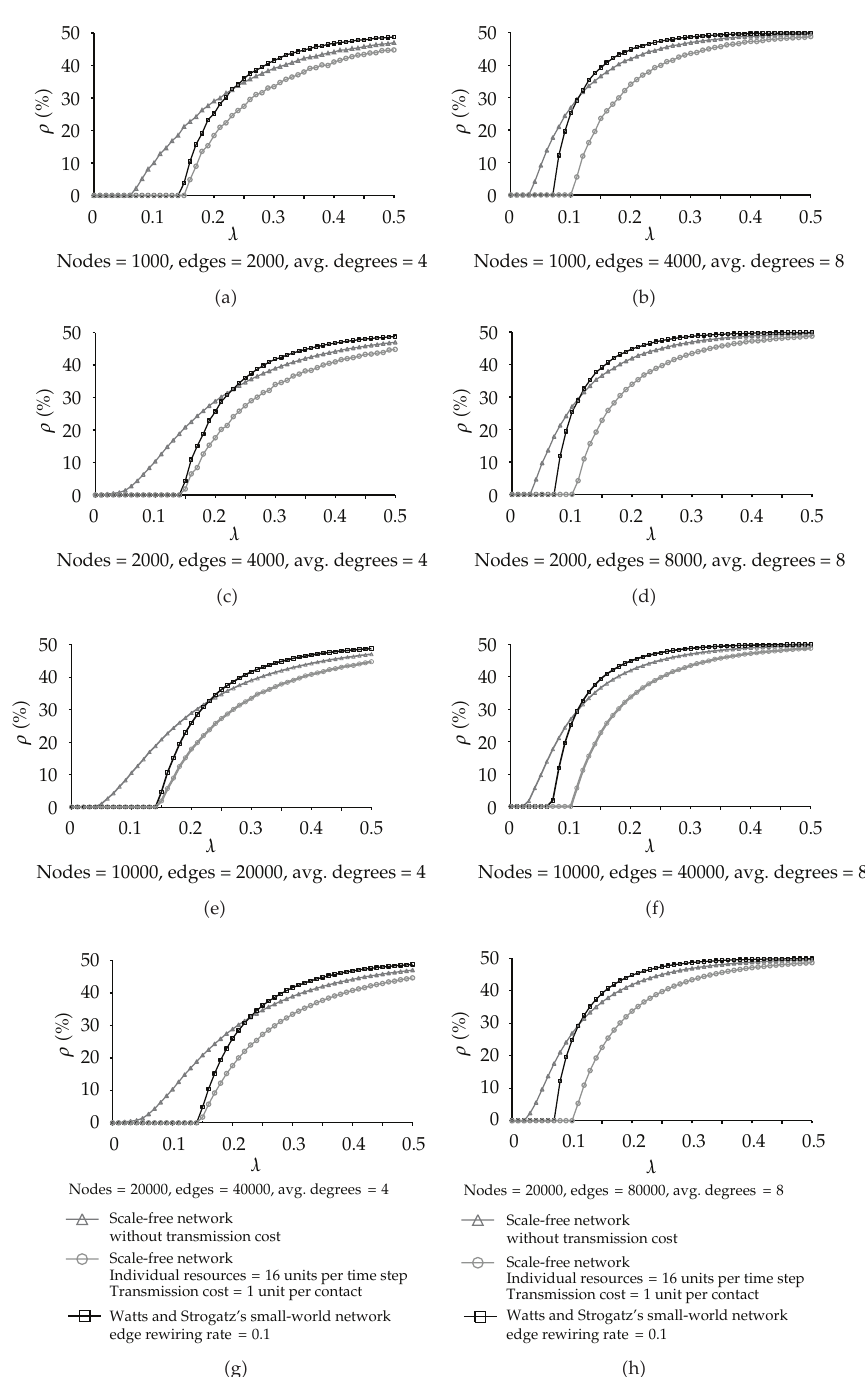
Figure 3: Relationship between e ff ective spreading rate and steady density in our epidemic model according to three types of complex network platforms: small world; scale-free without interaction costs; scale-free with limited resources and interaction